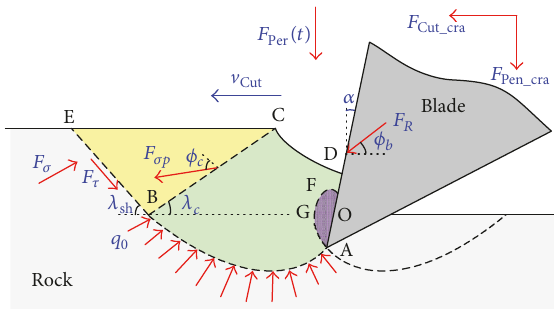
Figure 7: Stress analysis for lunar rock simulant fracture via an elemental blade by means of coupled impact and